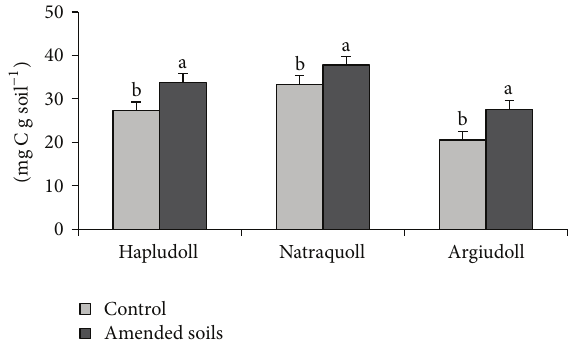
Figure 1: Storage capacity of biosolids-borne C of typical soils of the Pampas region, Argentina, 360 days after biosolids application (application rate of 150 dry t/ha). Different letters for the same soil indicate significant differences at the 0.05 probability level (𝑛 = 4) . (Adapted from Torri et al.